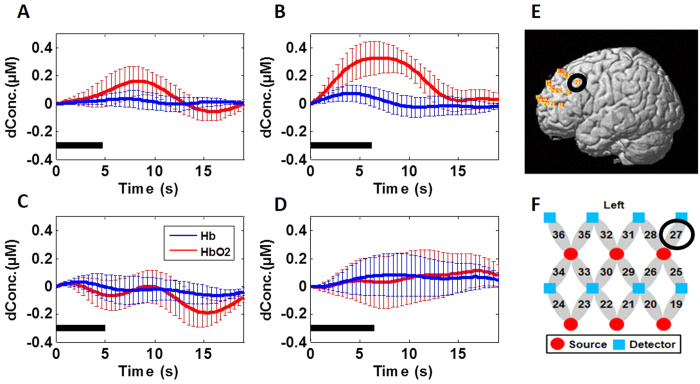
Mean Stroop-evoked hemodynamic changes of HbO2 in left pars opercularis (see channel 27 shown in Panels E,F) from both groups. (A,B) Group-averaged HbO2 response from the healthy group evoked by Stroop1 and Stroop2 tasks, respectively. (C,D) Group-averaged HbO2 response from the subjects with PTSD evoked by Stroop1 and Stroop2, respectively. In all four panels, the thick black bars represent the stimulation periods; the red lines represent the mean time courses of HbO2; the blue lines represent the mean time courses of Hb; the error bars represent the standard errors of mean. (E) It shows the position or location of channel 27 on a standard human brain template. (F) It shows the configuration of fNIRS channels on the left frontal cortex. Red circles represent light sources, blue squares represent detectors, and gray ellipses represent the nearest source-detector pairs (as channels) to measure the brain activities.